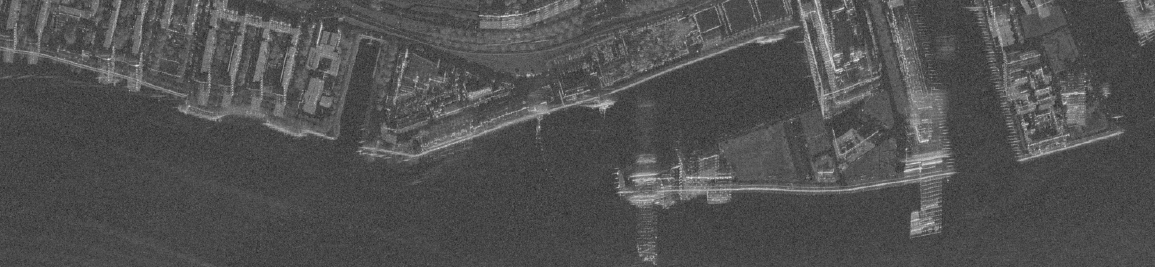
Figure 3. One of the SLC stripes after preprocessed and cropped to the boundaries of the testing set labels. These will be further cropped into non-overlapping tiles and later used as our validation